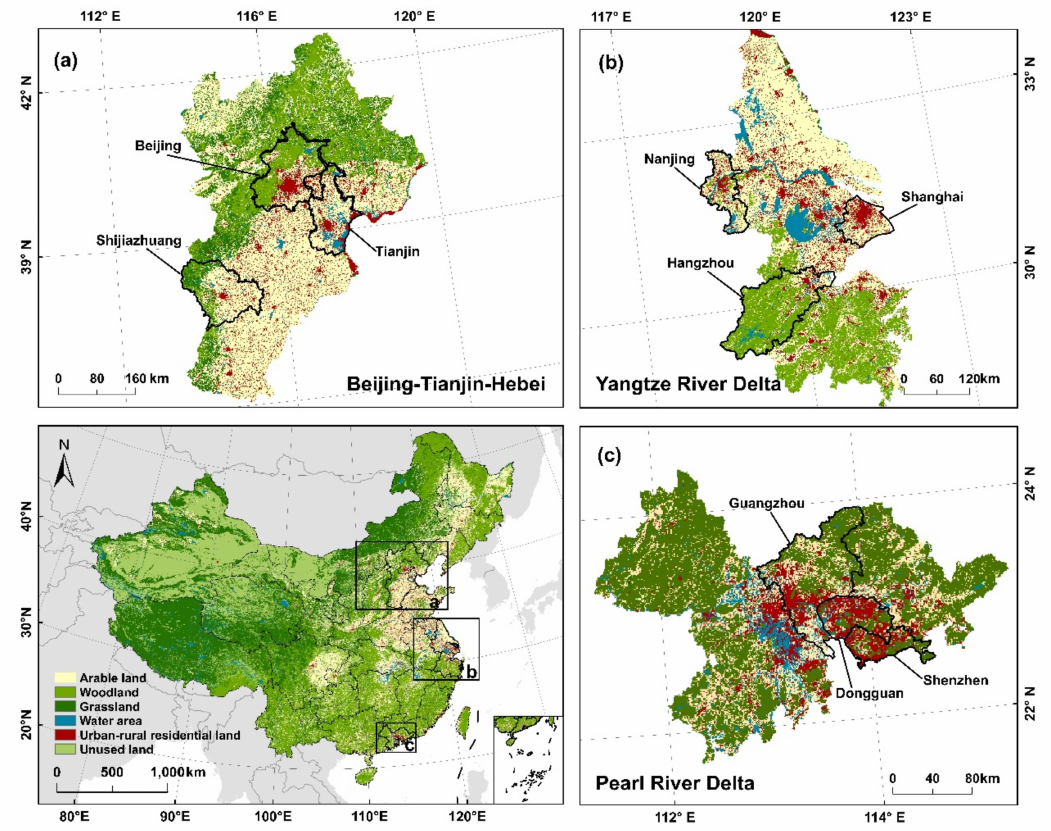
Figure 1. Locations of the study regions considered in this study. ( a ): The Beijing–Tianjin–Hebei region; ( b ): the Yangtze River Delta region; ( c ): the Pearl River Delta